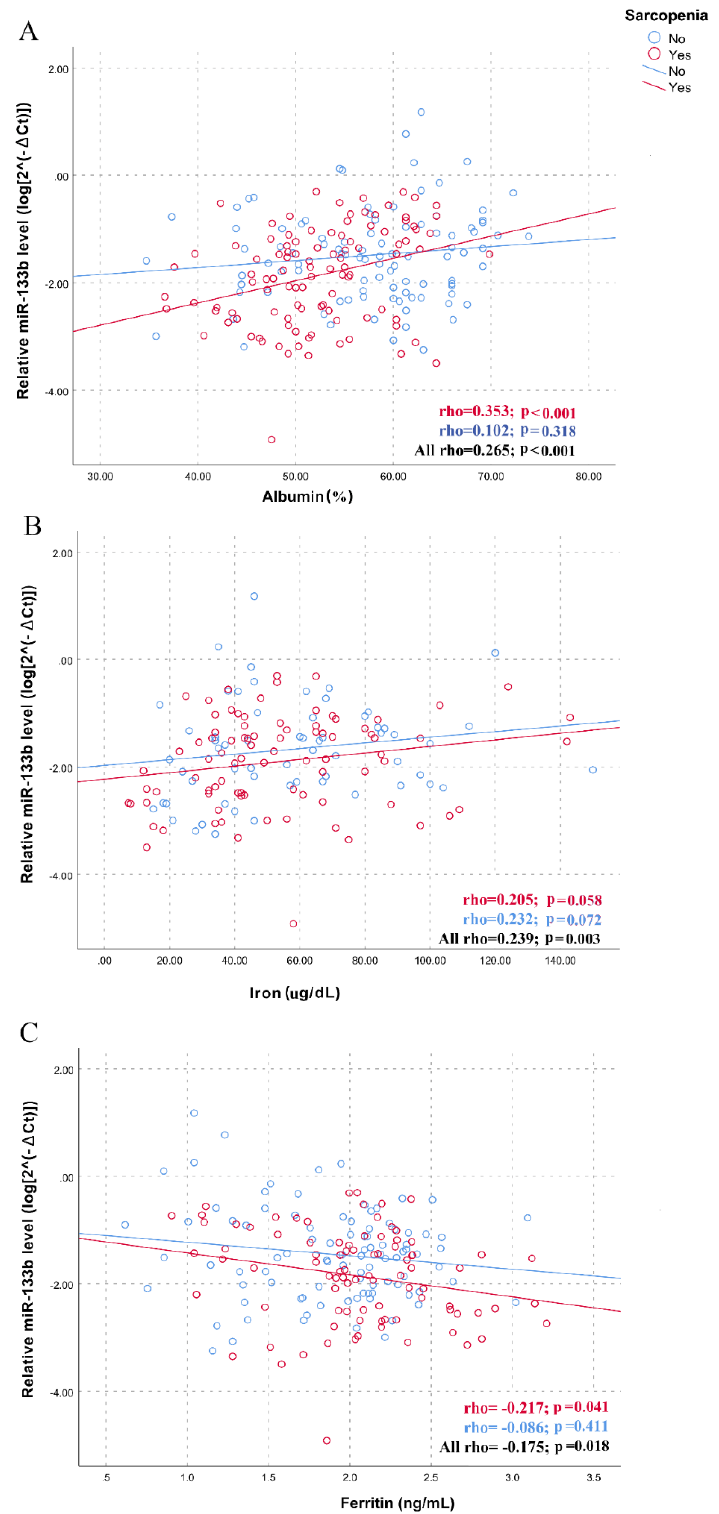
Figure 3. Correlations between plasma miR-133b levels and biochemical variables in sarcopenic and non-sarcopenic subjects. Scatter plots illustrate the relationship between plasma miR-133b levels and ( A ) albumin, ( B ) iron, ( C ) ferritin. Data are reported as log 2 − ∆ Ct normalized to U6